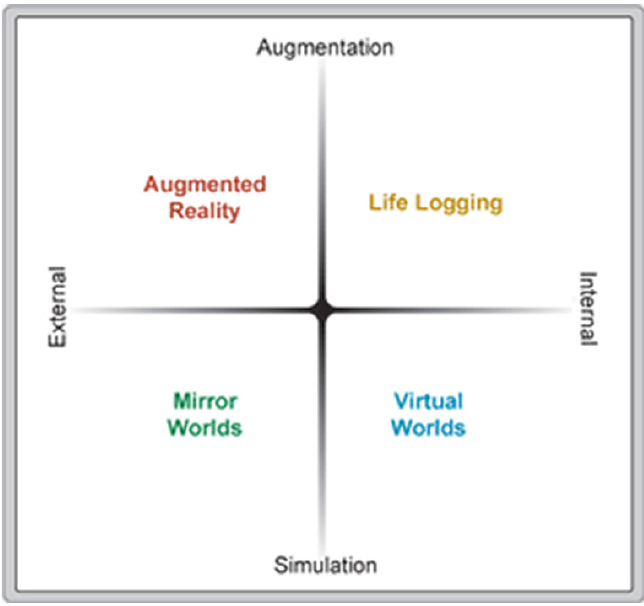
Fig. 1. Categories and dimensions for the